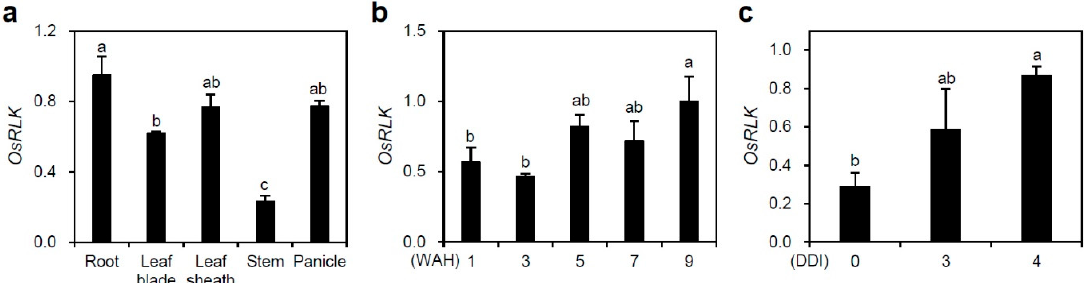
Figure 1. Expression patterns of rice senescence-induced receptor-like kinase ( OsSRLK ). ( a ) OsSRLK was differentially expressed in various wild-type (WT) tissues separated from root, leaf blade, leaf sheath, stem, and panicles at the heading stage. ( b,c ) Transcript levels of OsSRLK were determined in the flag leaves of WT grown in the paddy field under natural long day (NLD) conditions ( ≥ 14 h light/day) ( b ) or in the detached leaves of WT grown in the growth chamber for three weeks under long day (LD) conditions (14 h light/10 h dark) ( c ). The transcript levels of OsSRLK were determined by RT-qPCR analysis and normalized to those of OsUBQ5 (AK061988). Mean and standard deviations were obtained from more than three biological replicates. Different letters indicate significant differences according to one-way ANOVA and Duncan’s least significant range test ( p < 0.05). These experiments were repeated twice and gave similar results. WAH, week(s) after heading; DDI, day(s) of dark incubation.